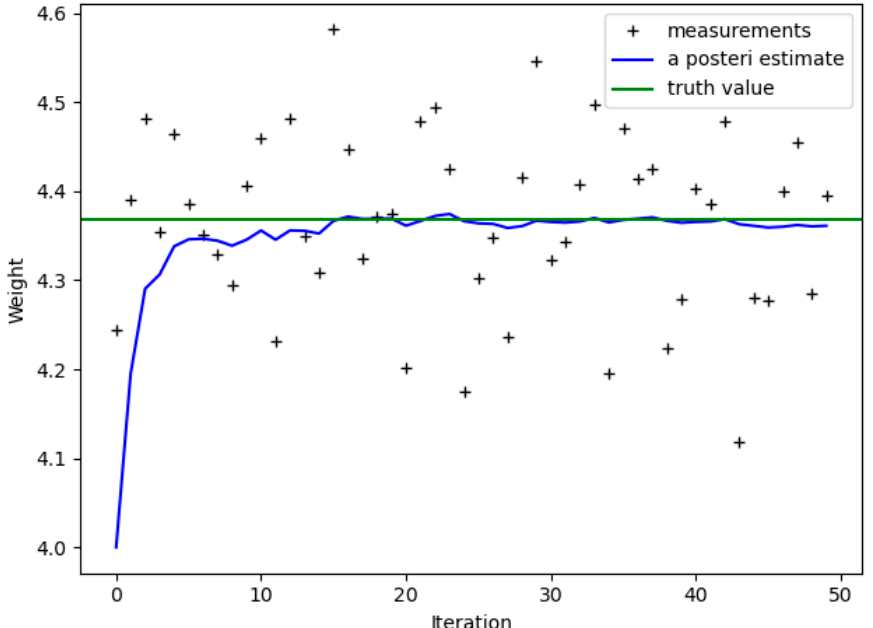
Figure 3. Simulation model of the Kalman filter.